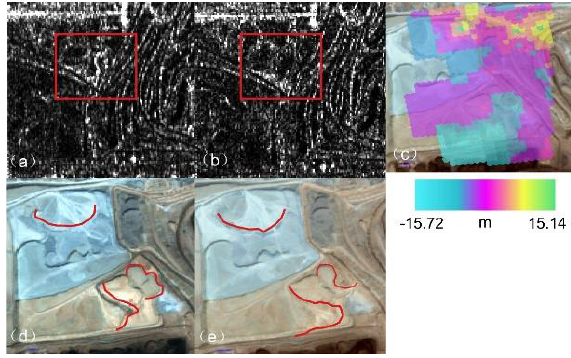
Figure 6. Topographic changes and displacement of the dump